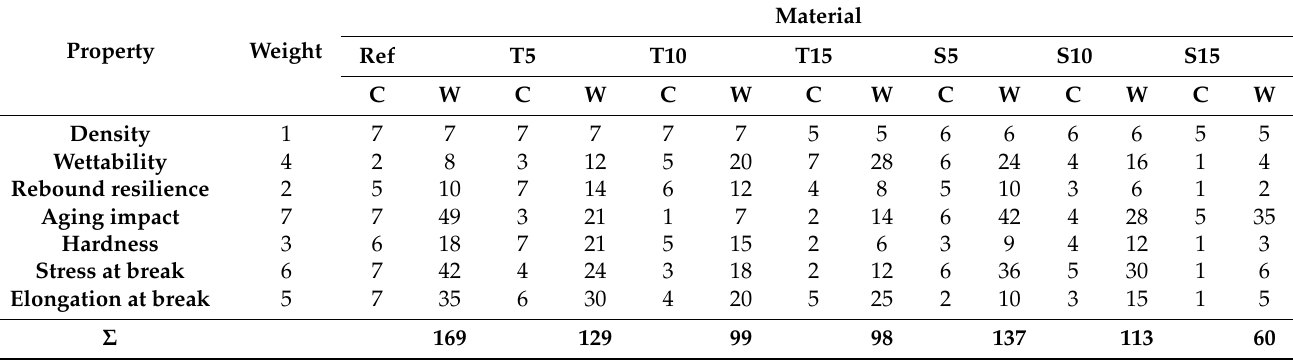
Table 6. Multiple-criteria